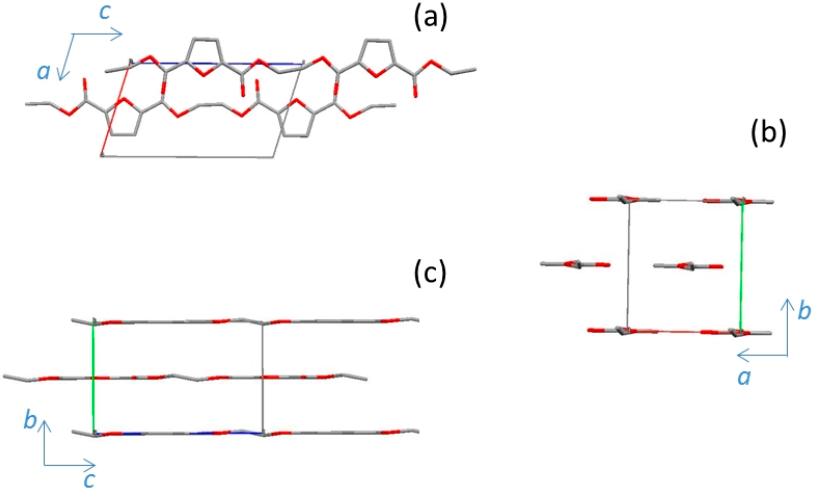
Figure 5. Views of the chain packing for the β -PEF structure: ( a ) along the b -axis; ( b ) projection down the c -axis; ( c ) projection down the a -axis. Oxygen atoms are in red.